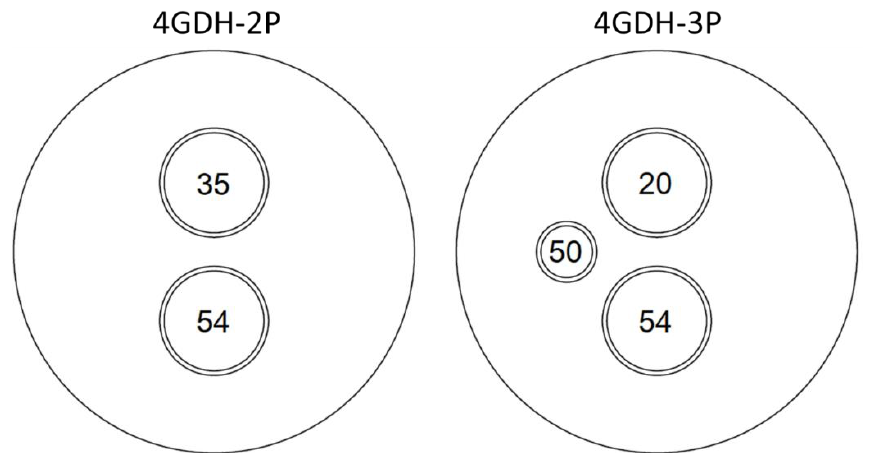
Figure 2. Visual representation of the current twin-pipe configuration (4GDH-2P) compared to the potential 4GDH-3P pipe configuration for DN65, with three insulation standards in geometry and for temperatures according to [10]. The third pipe in 4GDH-3P is displaced three sizes downward (i.e., a DN32 pipe is utilised).